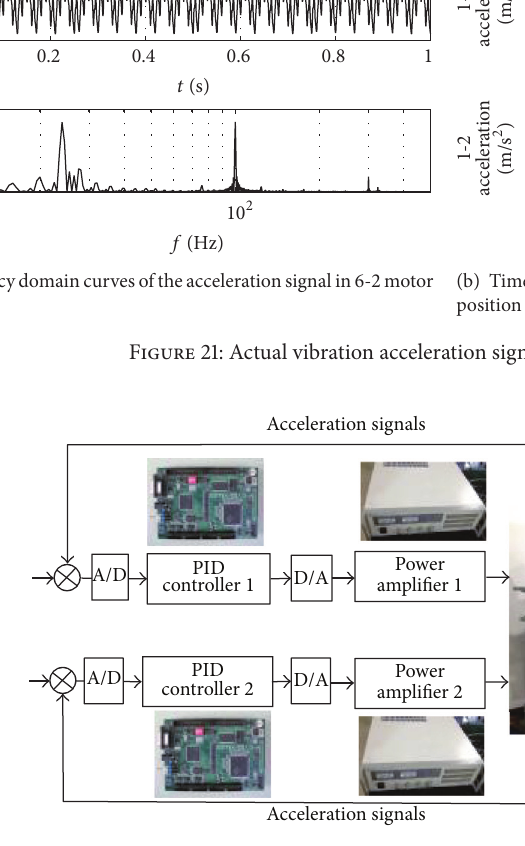
Figure 22: Control block diagram of multiexcitation active vibration isolation experiment